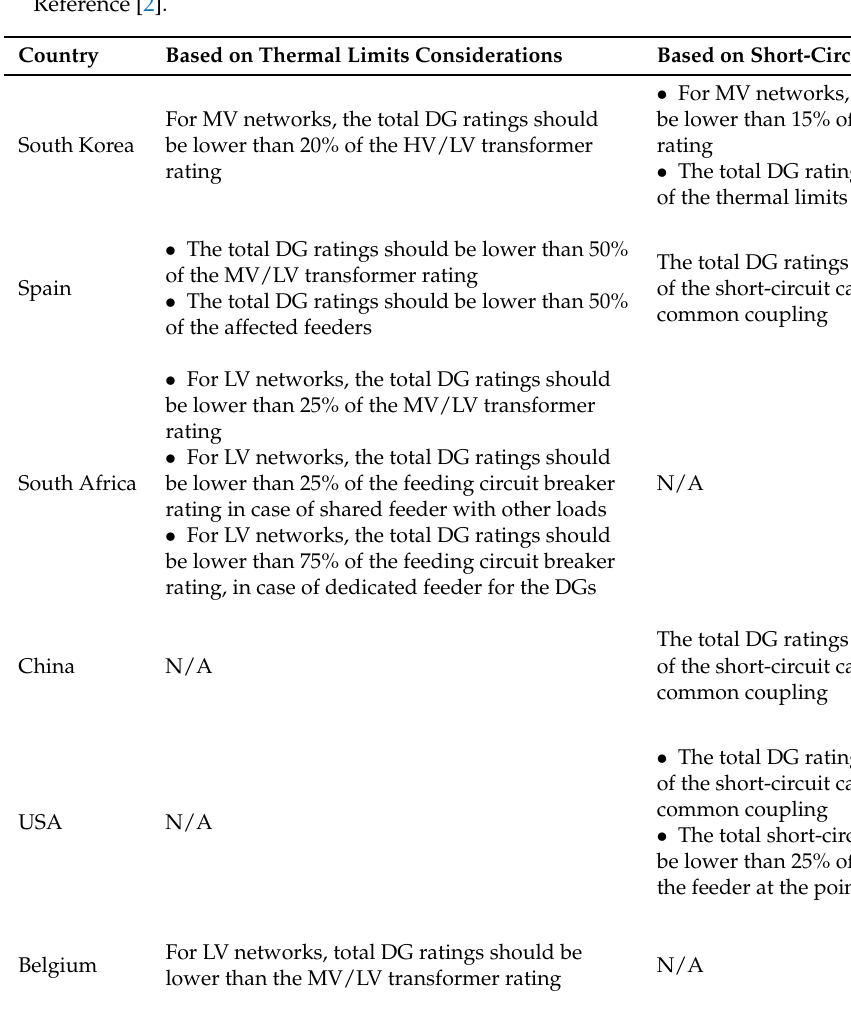
Table 1. International Distribution System Operator (DSO) experiences and rules of thumb for Distributed Generation (DG) interconnections. Adapted from Reference